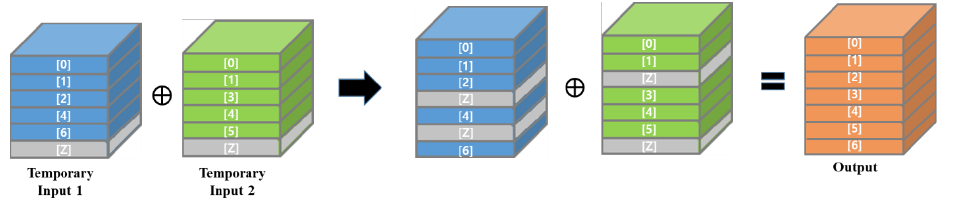
Figure 9. Gather Figure 9. Gather method.